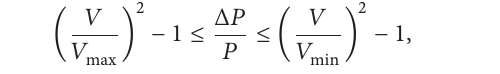
Figure 8: Experimental circuit diagram by use of inverter.